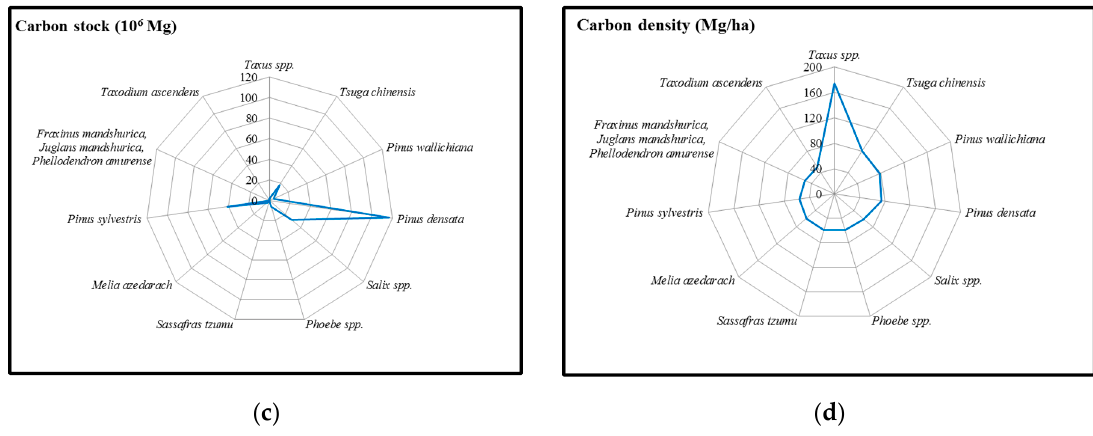
Figure 5. Species with carbon densities greater than the national average that occupy <1% of total arboreal forest area. Subfigures ( a ), ( b ), ( c ) and ( d ) are occupied area, biomass, carbon stock and carbon density of these species, respectively.